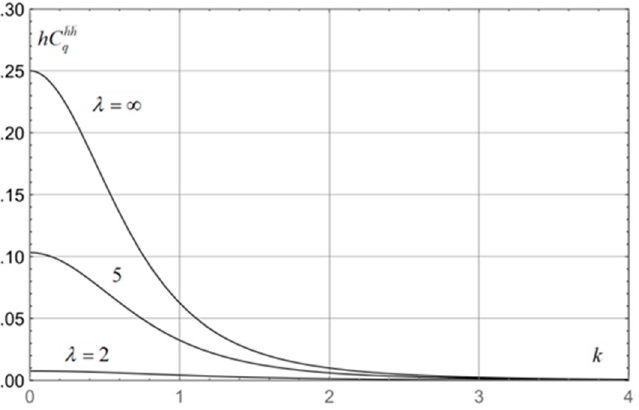
.. .. .. .. =   =   h h h h =   = C with respect to ver- with respect to ver- with respect to ver- s with respect to t